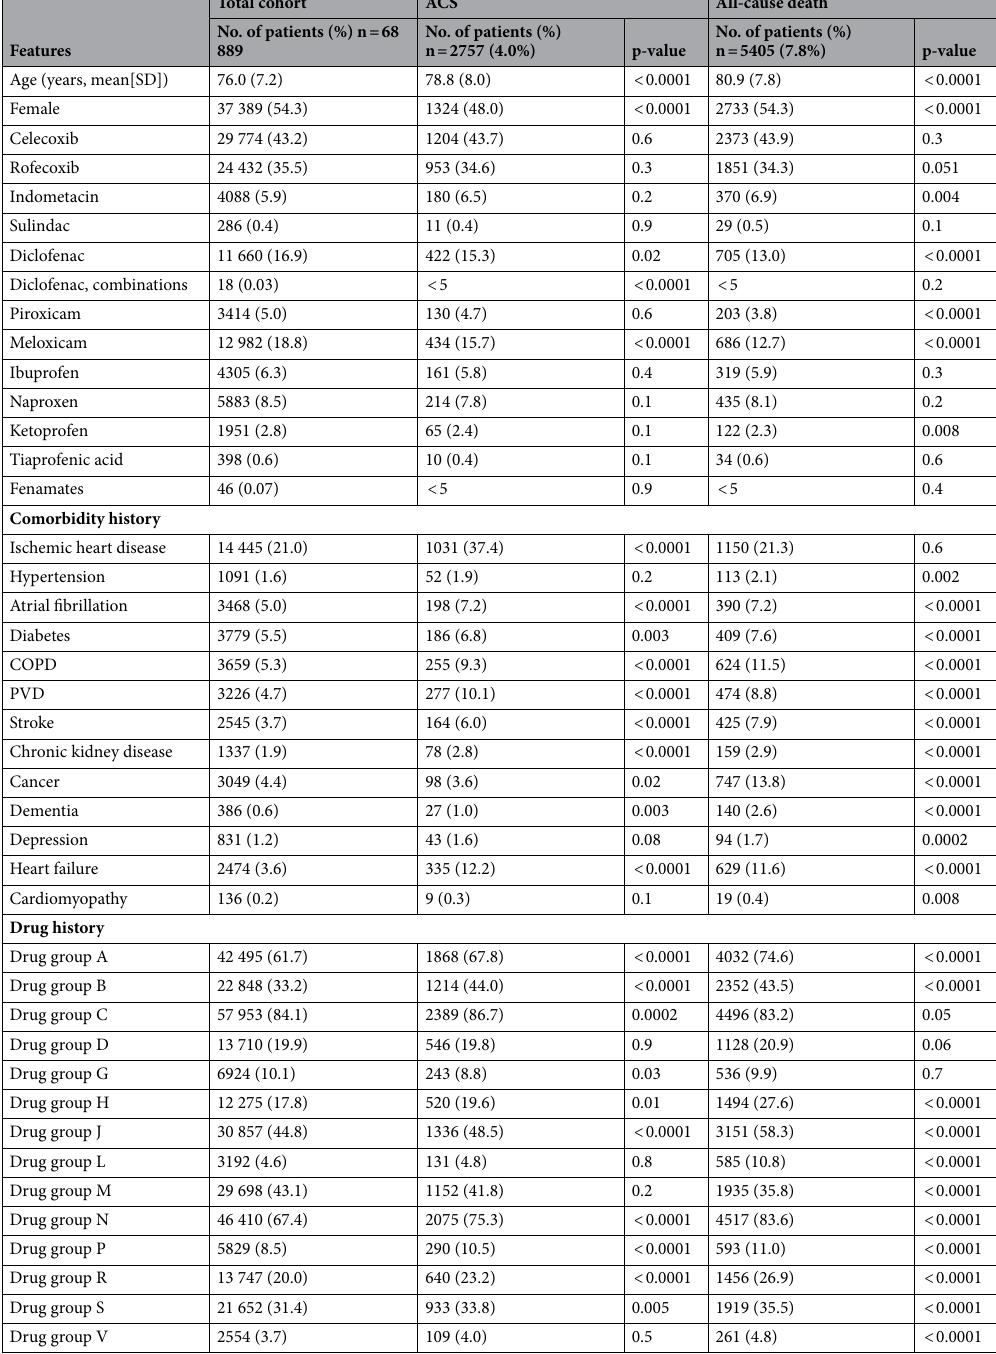
Table 1. Characteristics of the study cohorts for NSAIDs during 2003–2004. SD standard deviation, COPD chronic obstructive pulmonary disease, PVD peripheral vascular disease, ACS acute coronary syndrome. Drug groups: A alimentary tract and metabolism, B blood and blood forming organs, C cardiovascular system, D dermatologicals, G genito urinary system and sex hormones, H systemic hormonal preparations, J anti- infectives for systemic use, L antineoplastic and immunomodulating agents, M musculo-skeletal system, N nervous system, P antiparasitic products, R respiratory system, S sensory organs, V